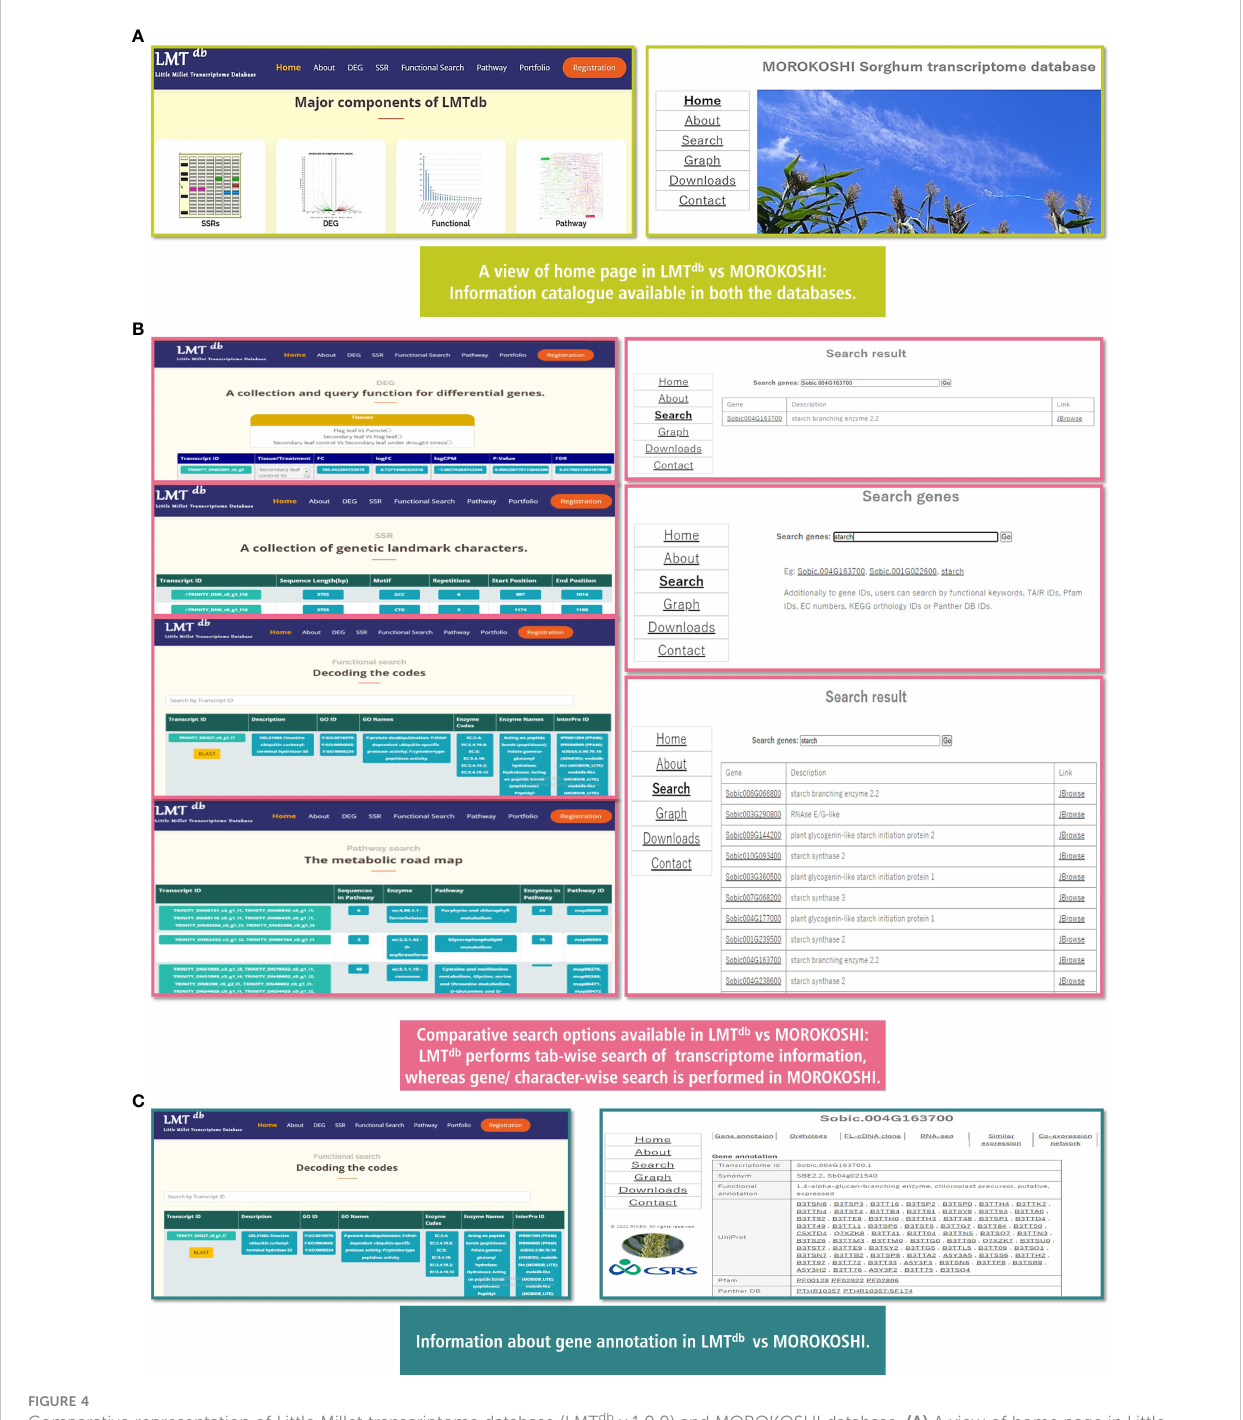
FIGURE 4 Comparative representation of Little Millet transcriptome database (LMT db v.1.0.0) and MOROKOSHI database. (A) A view of home page in Little Millet Transcriptome Database (LMT db v.1.0.0) vs MOROKOSHI Database. (B) Comparative search options available at Little Millet